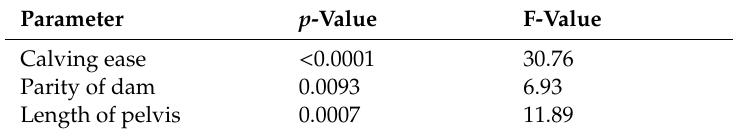
Table 7. p -values and F-values of parameters in the hierarchical model for perinatal mortality